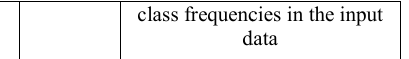
algorithm.class Table 6. Optimal hyperparameters for Fig. 6. Accuracies obtained using the Logistic Regression algorithm. Fig. 4. Accuracies obtained using our algorithm locate pedestrians. Fig. 7. Accuracies obtained by Gaussian Naive Bayes. Fig. 5. Accuracies obtained using the SVC Fig. 8. Accuracies obtained by Random Forest